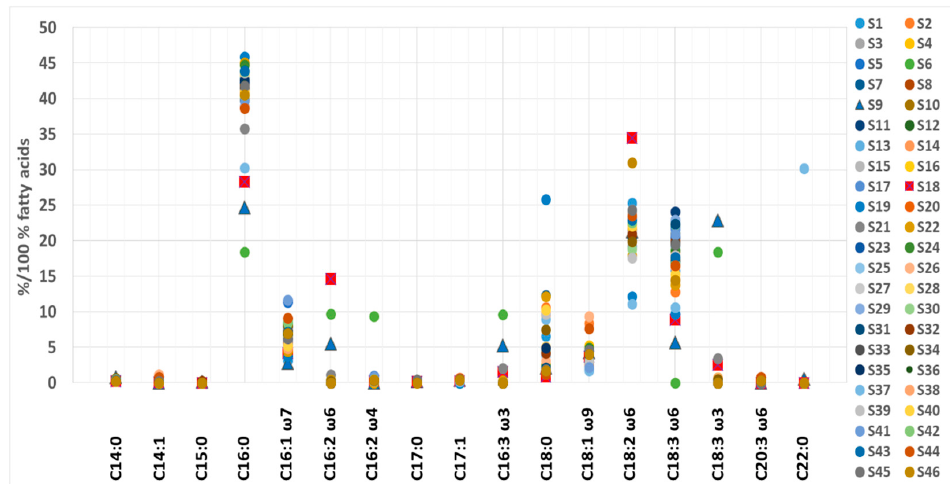
Figure 2. The fatty acid content range in Spirulina -based supplements.